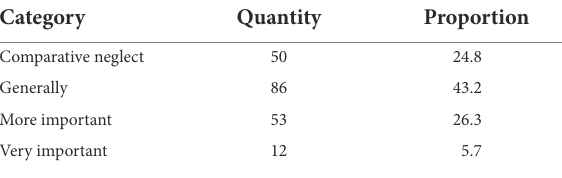
TABLE 3 Basic situation of international talent cultivation concept in universities.